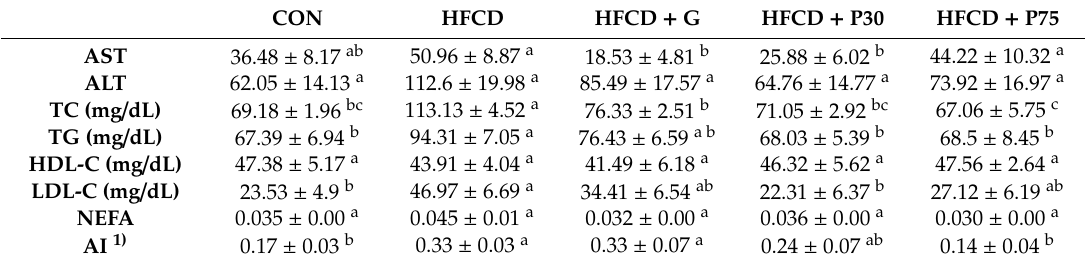
Table 3. E ff ects of PEITC supplementation on the serum levels of lipid associated molecules.